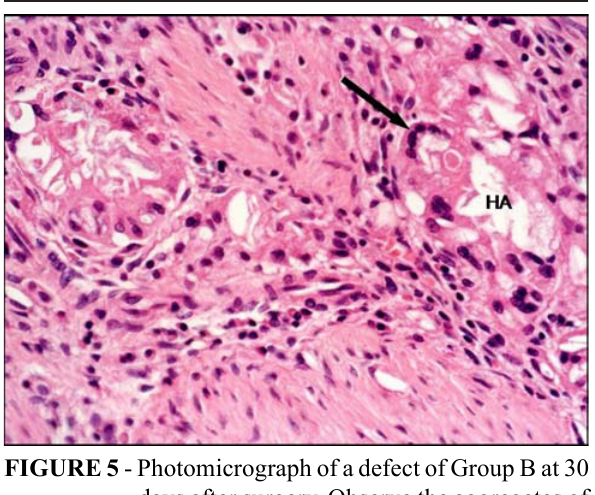
FIGURE 5 - Photomicrograph of a defect of Group B at 30 days after surgery. Observe the aggregates of micro-particles (HA) surrounded by giant cells (arrow) HE,